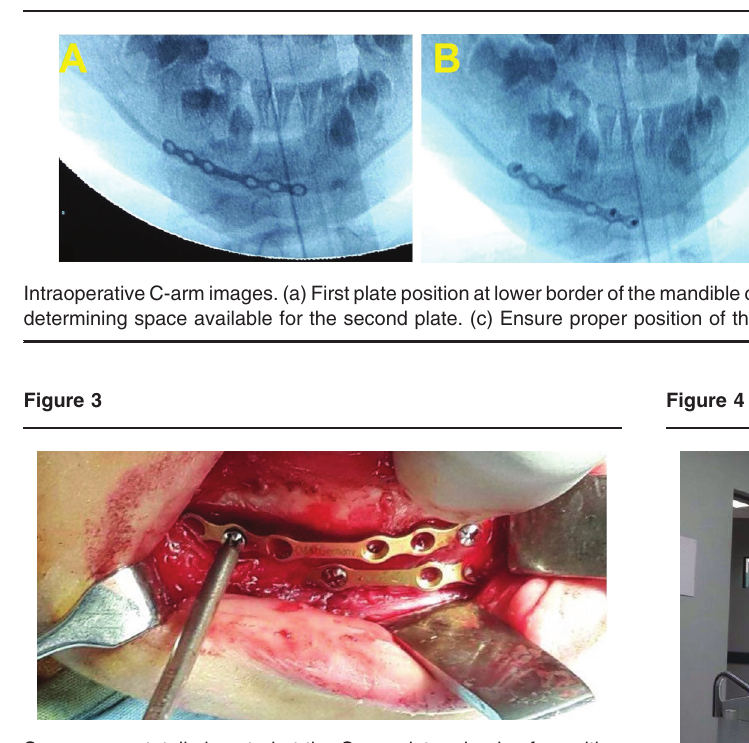
Screws were totally inserted at the C-arm-determined safe position avoiding screw insertion in plate hole near to tooth bud and using plate with space to bypass risky area.